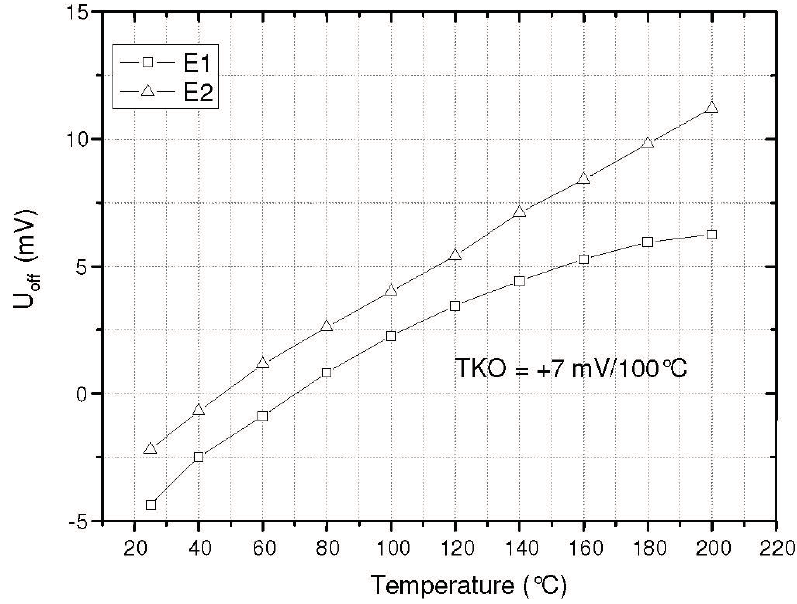
Figure 11. Offset voltage measured with the fabricated sensor [9].